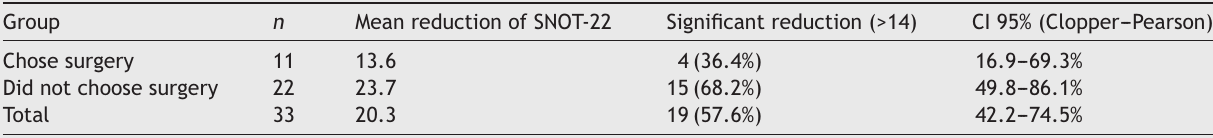
Post-treatment results of SNOT-22.